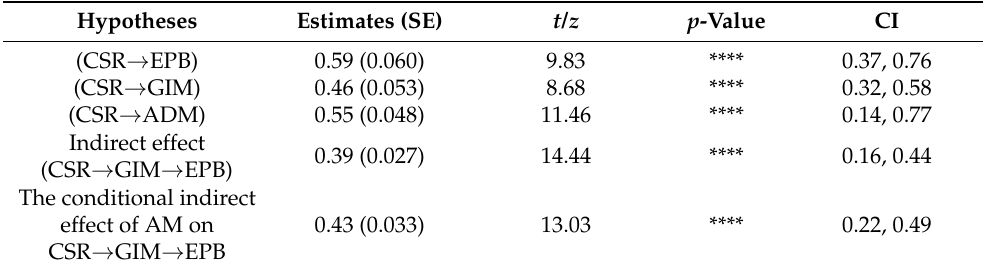
Table 6. Hypotheses